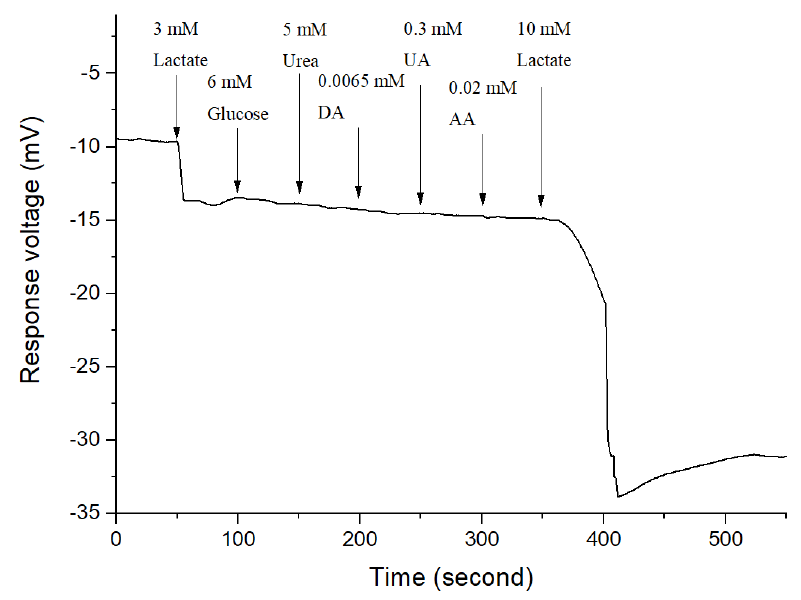
Figure 10. The interferences effect of the flexible lactate biosensor based on CZO film/FePt NPs after adding 6.00 mM glucose, 5.00 mM urea, 0.06 mM dopamine (DA), 0.30 mM uric acid (UA), 0.02 mM ascorbic acid (AA), and 10.0 mM